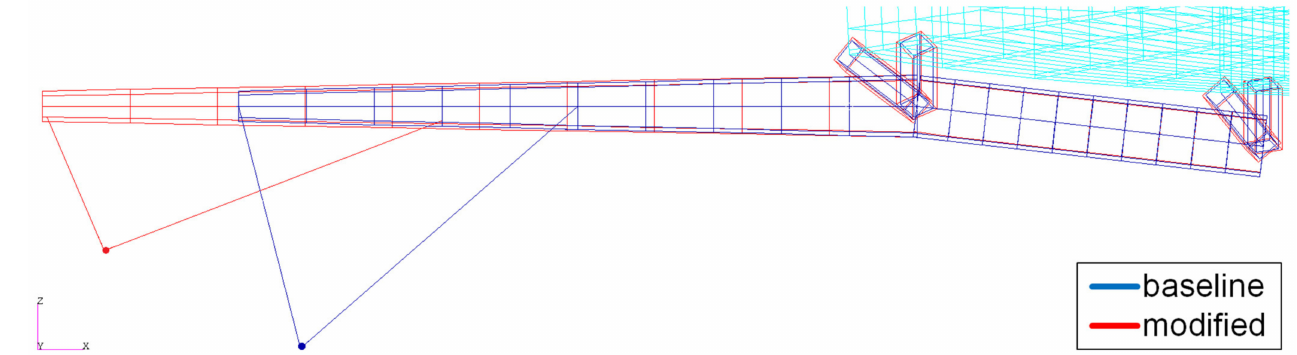
Figure 9. Pylon structural model visualization of the baseline and modified